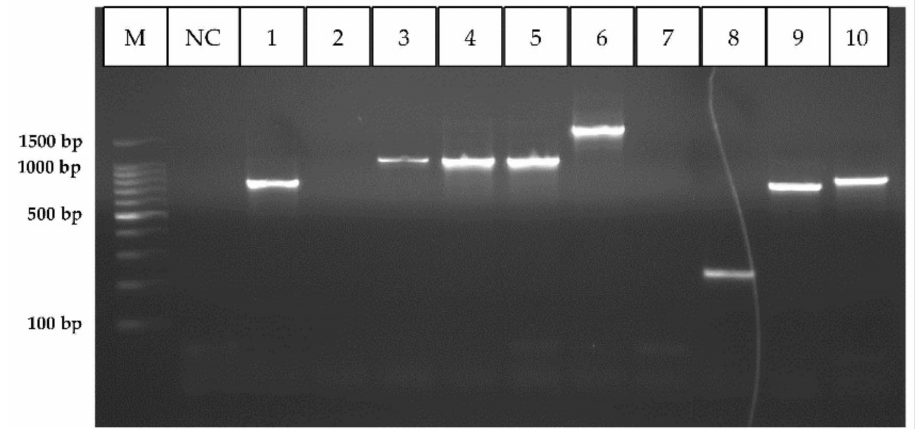
Figure 6. PCR gel image showing the positive amplicons of class 1 integron gene cassette regions. M: Molecular weight marker (100 bp), NC: negative control, Lane numbers 1,3–6,8–10—Positive; 2 and